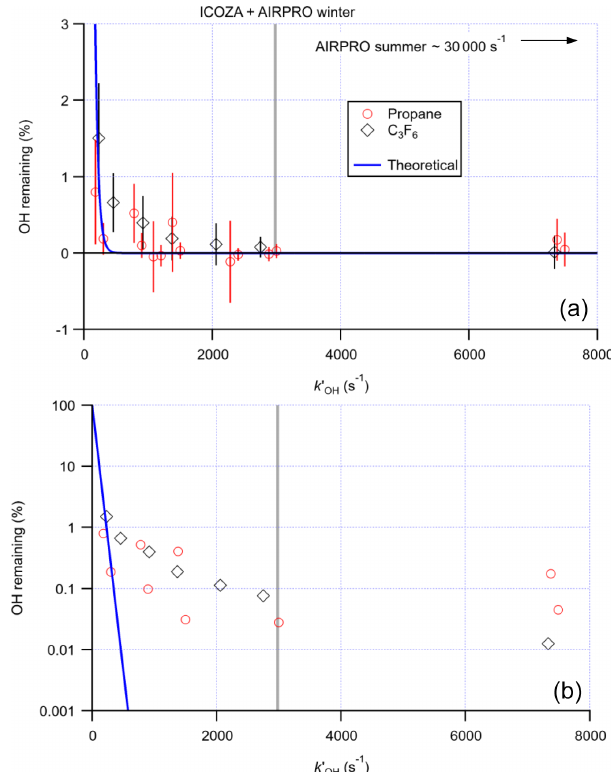
Figure 5. Proportion of the OH signal remaining (i.e. external OH removal efficiency) after addition of increasing concentrations of propane and perfluoropropene (C 3 F 6 ) scavengers to the IPI flow tube, converted to equivalent OH reactivities ( k (cid:48) ) to account for OH the different rate constants for the reaction of each scavenger with OH: (a) linear y scale, (b) log y scale. Error bars denote the 2 σ SD of repeat experiments. The blue curve corresponds to the theoreti- cal scavenging efficiency assuming perfect mixing, using the esti- mated residence time, τ ∼ 20ms. The propane OH reactivity used for the ICOZA (Integrated Chemistry of OZone in the Atmosphere) and AIRPRO winter campaigns is given but that used for AIRPRO summer is